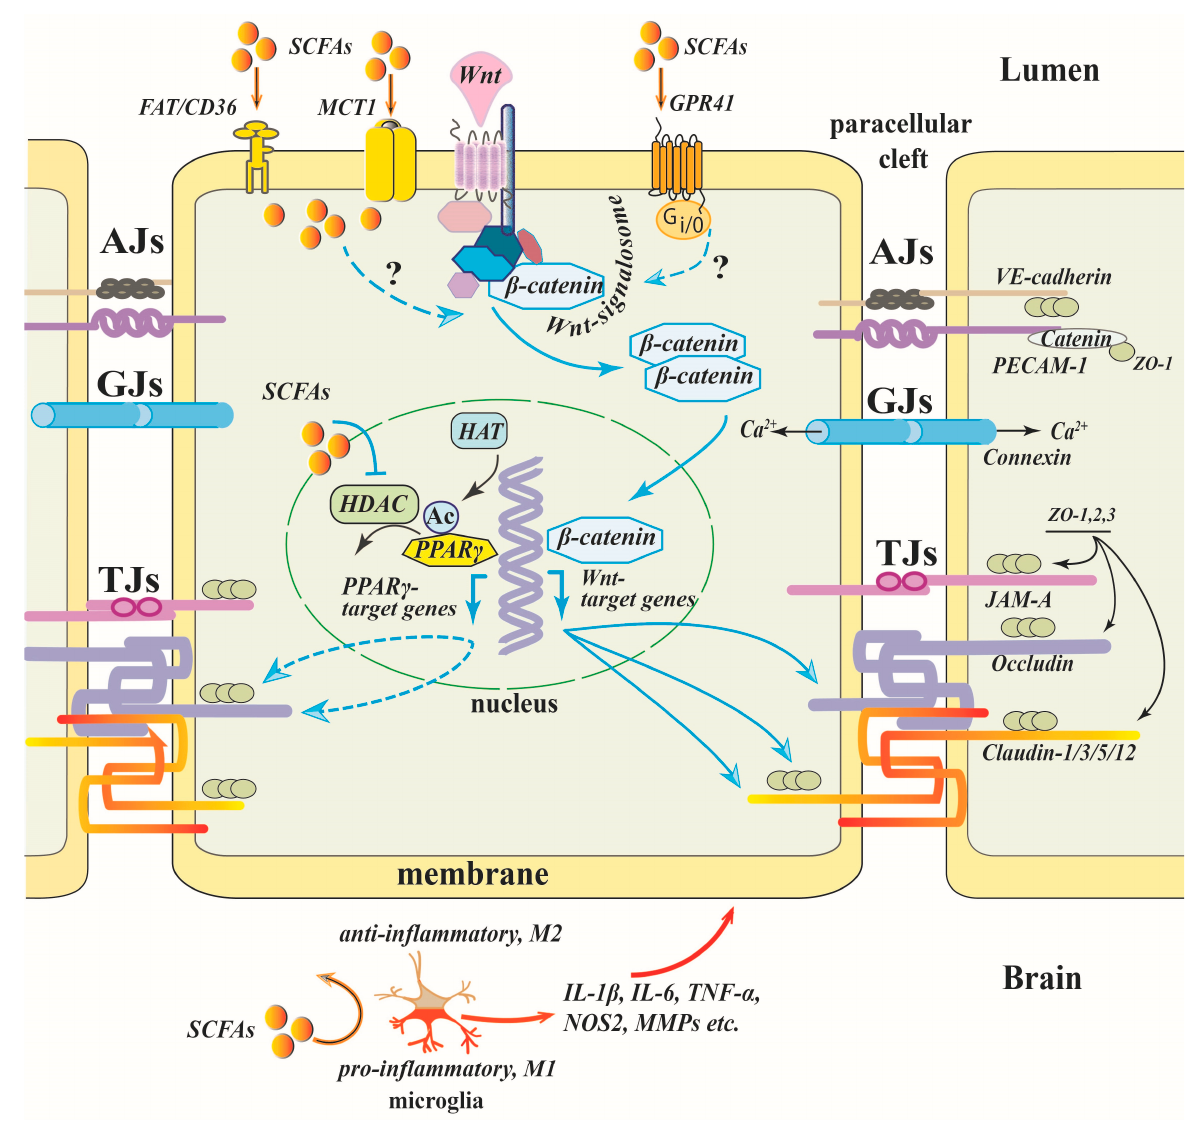
Figure 3. Mechanisms of SCFA effects on a brain endothelial cell (Part 2). Inhibition of HDAC by SCFAs leads to hyperacetylation of PPAR γ and its translocation into the nucleus potentiating transcription of TJPs. Activation of the Wnt signaling pathway promotes translocation of β -catenin into the nucleus and upregulation of transcription of ZO-1, occludin and claudin-5. The crosstalk between SCFA signaling and the canonical Wnt/ β -catenin pathway could be presumed. SCFAs can interact with microglia by binding to G-protein receptors or by inhibiting HDAC, suppressing their activation. Dotted lines—putative signaling pathways. Symbols on the scheme—see in the list of abbreviations.